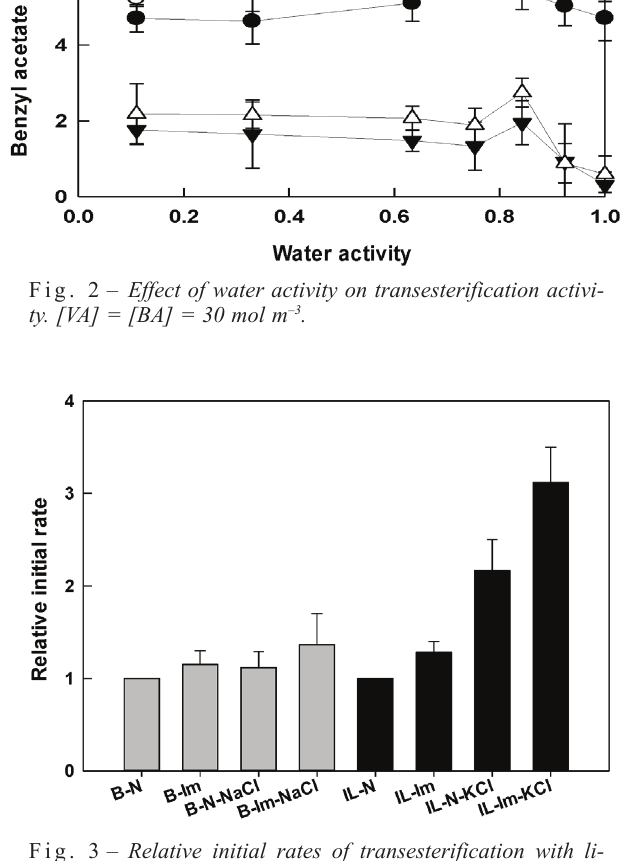
Fig. 3 – Relative initial rates of transesterification with li- pases based on those with native lipases. B: benzene, IL: mim][PF ], N: native, Im: imprinted. NaCl and KCl denote [C 4 6 solvents treated with saturated NaCl (a = 0.7528) or KCl (a w w = 0.8426) aqueous solution. [VA] = [BA] = 30 mol m –3 . Rela- tive initial rates were defined as ratio of initial rates with treat- ed lipase in treated organic media to those with native lipase in untreated organic media; relative initial velocities of B-N and IL-N are